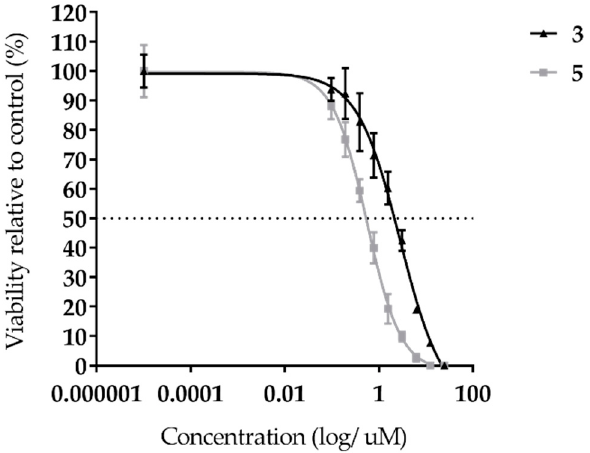
Figure 5. Dose–response curves for ferrocene analogues, 3 and 5 in MDA-MB-231 cells. Cells were treated for 72 h and assessed by Cell Titer Blue assay. Data shown as mean ± standard deviation (SD) of triplicate wells and are representative of three independent experiments ( n = 3).